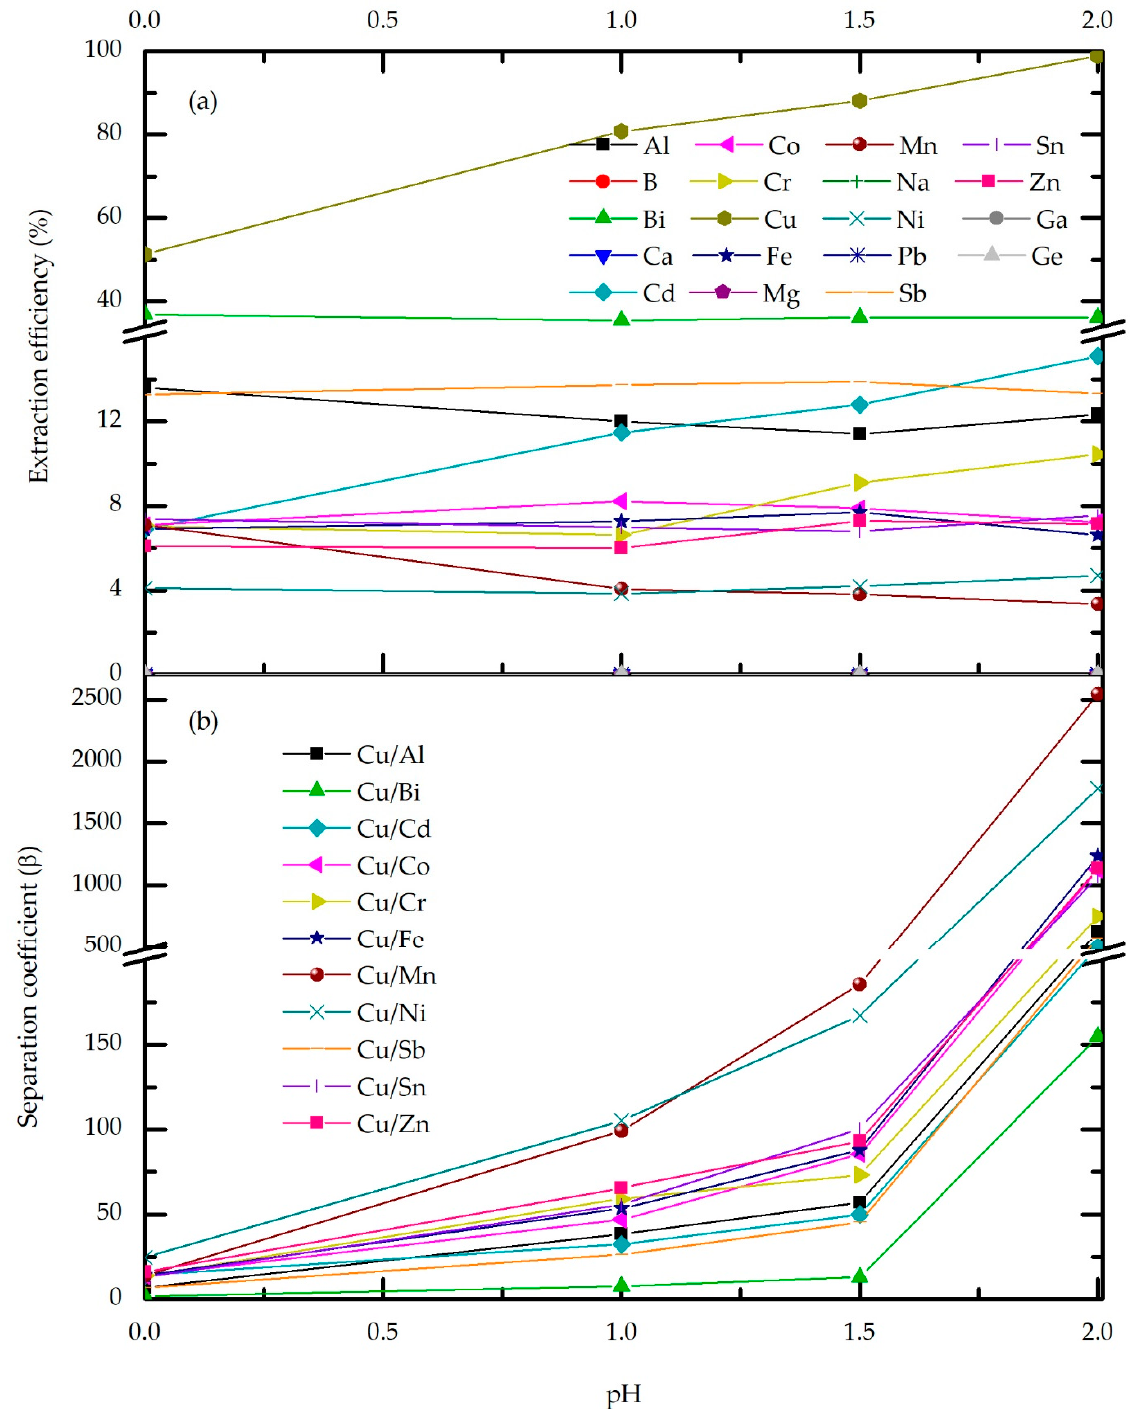
Figure 5. Effect of feed pH on the extraction efficiency ( a ) and Cu-metal separation factor ( b ) for M5640 20 vol.%, O/A = 3, temperature 20 °C and contact time 10 min.